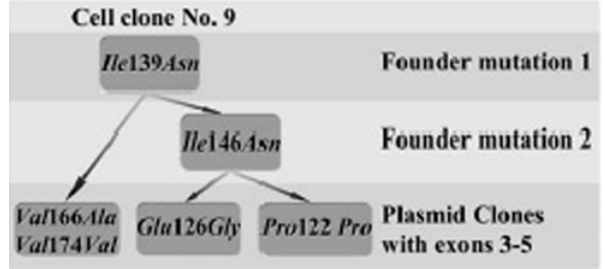
Figure 2. Flow chart showing accumulation of mutations (including two founder mutations) in RASSF1A exons 3–5 in the single cell clone # 9. Synonymous mutation Pro122Pro was caused by nucleotide change ATC R AAC. Mutation GTC R GTA also didn’t result in any amino acid change (Val174Val).